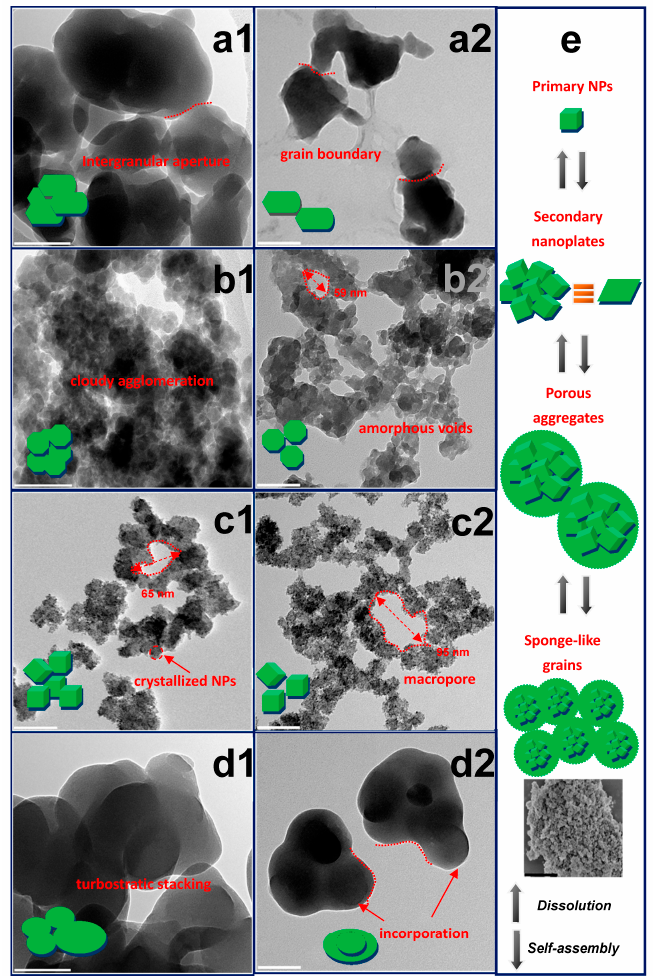
Figure 1. The particle morphology transformation illustrated by Transmission electron microscopy (TEM) images: ( a ) Sn ‐ HEDP; ( b ) Sn ‐ ATMP; ( c ) Sn ‐ EDTMP; ( d ) Sn ‐ DTPMP. The a1 – d1 , a2 – d2 (TEM) images: ( a ) Sn-HEDP; ( b ) Sn-ATMP; ( c ) Sn-EDTMP; ( d ) Sn-DTPMP. The a1 – d1 , a2 –